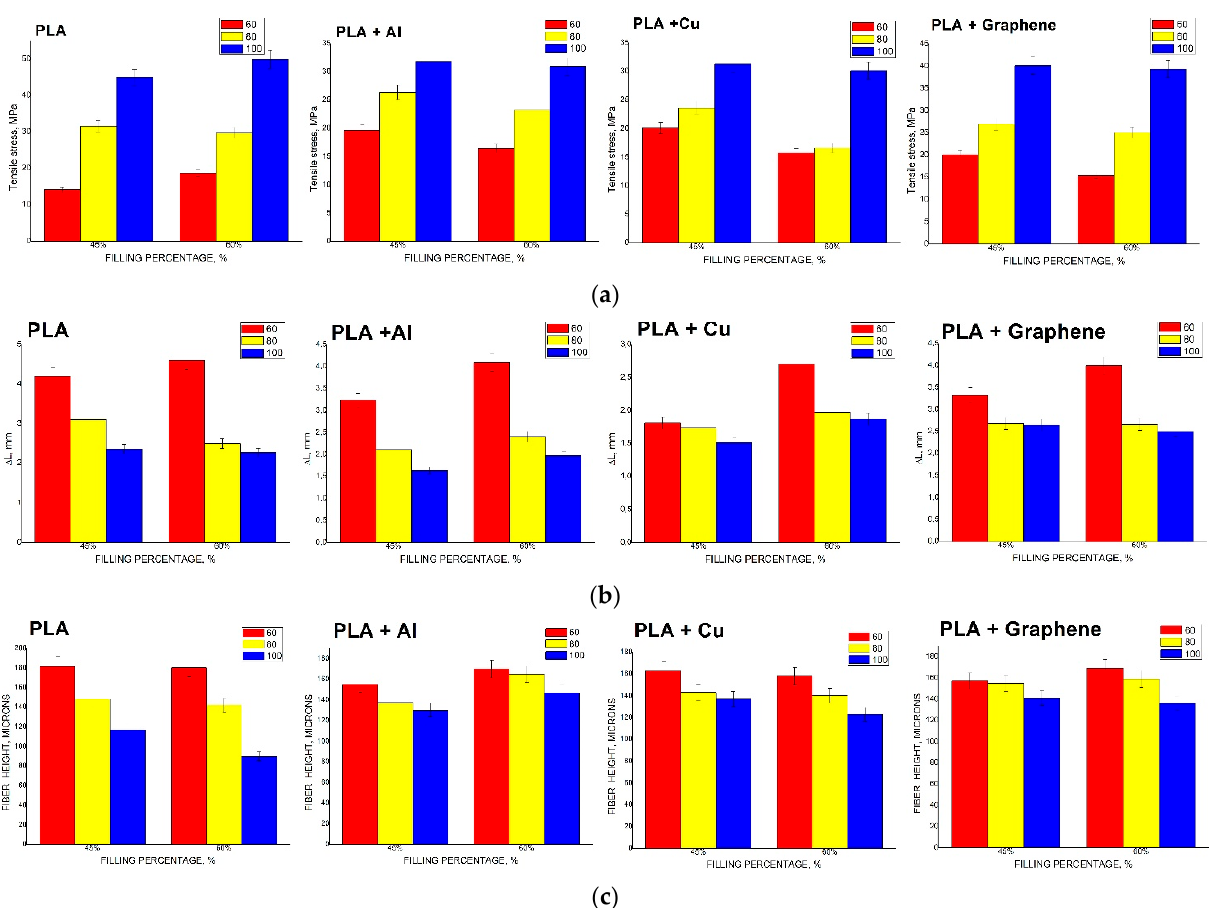
Figure 3. Tensile stress ( a ), elongation ( b ) and fiber heights ( c ) versus different 3D printing characteristics of the PLA with or without particle insertions (Cu, Al, graphene).